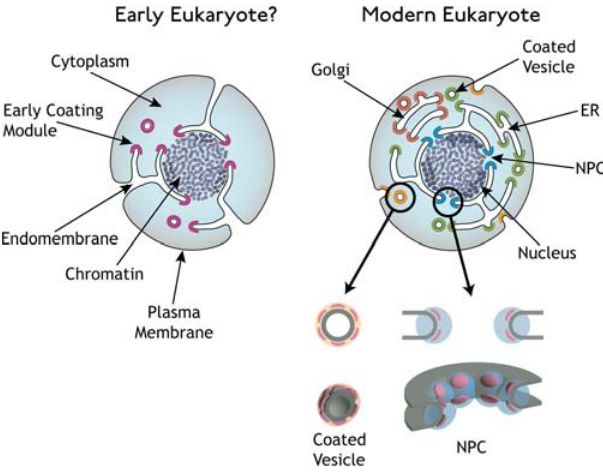
Figure 5. Proposed Model for the Evolution of Coated Vesicles and Nuclear Pore Complexes Early eukaryotes (left) acquired a membrane-curving protein module (purple) that allowed them to mold their plasma membrane into internal compartments and structures. Modern eukaryotes have diversified this membrane-curving module into many specialized functions (right), such as endocytosis (orange), ER and Golgi trans- port (green and brown), and NPC formation (blue). This module (pink) has been retained in both NPCs (right bottom) and coated vesicles (left bottom), as it is needed to stabilize curved membranes in both cases. DOI: